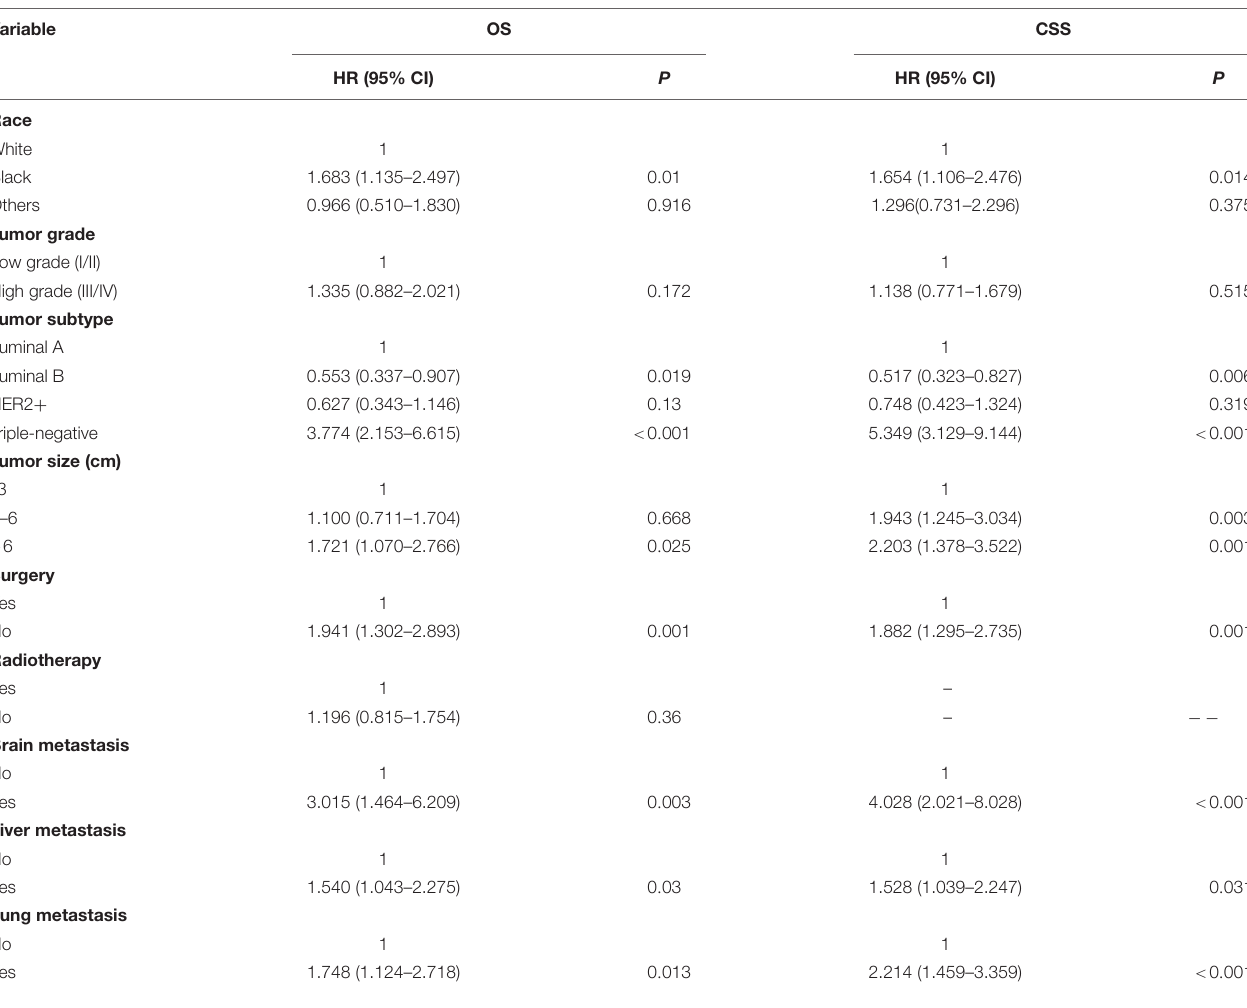
TABLE 3 | Multivariate Cox regression analysis of survival in the training